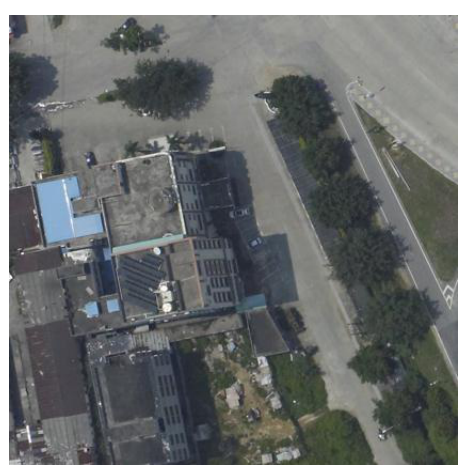
Figure 4. Occlusion Detection